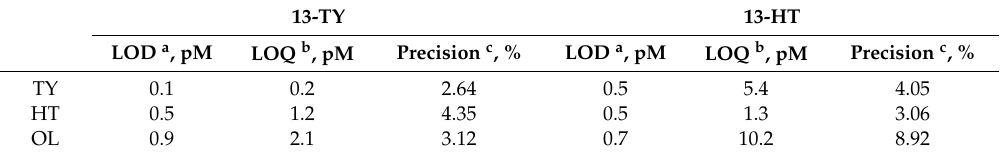
Table 3. Sensitivity and precision of MIP fluorescence